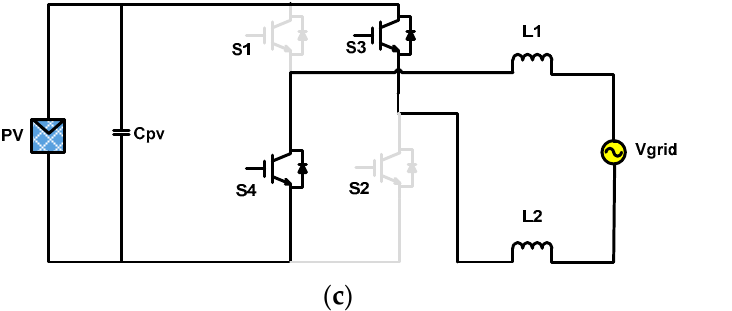
Figure 5 . Full-bridge (H4) inverter connected to the grid. ( a ) H4 inverter circuit, ( b ) current conduc- tion during the positive half cycle of grid voltage and ( c ) current conduction during the negative half cycle of grid voltage.